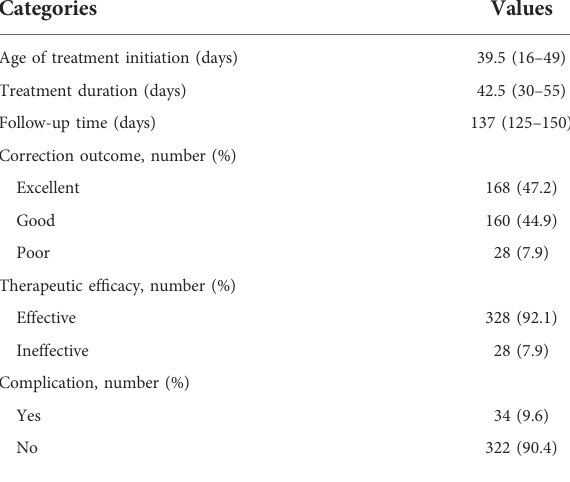
TABLE 2 Treatment outcomes of 356 ear deformities.